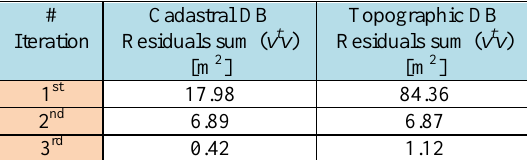
Table 1. Residuals for both databases during